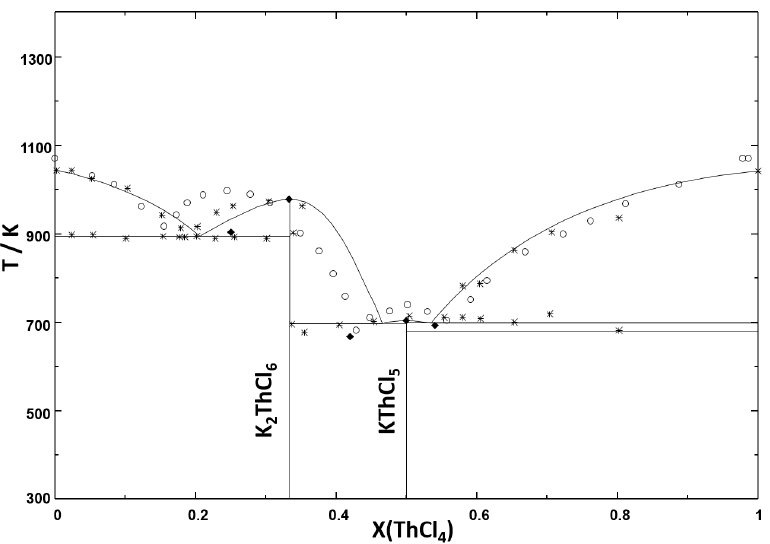
Figure 2. The NaCl-ThCl 4 phase diagram as calculated in this work. Symbols: phase diagram data reported by Tanii [21] ( ˚ ), Oyamada [19] ( ˝ ), and Vokhmyakov et al. [20] ( ˛ ).